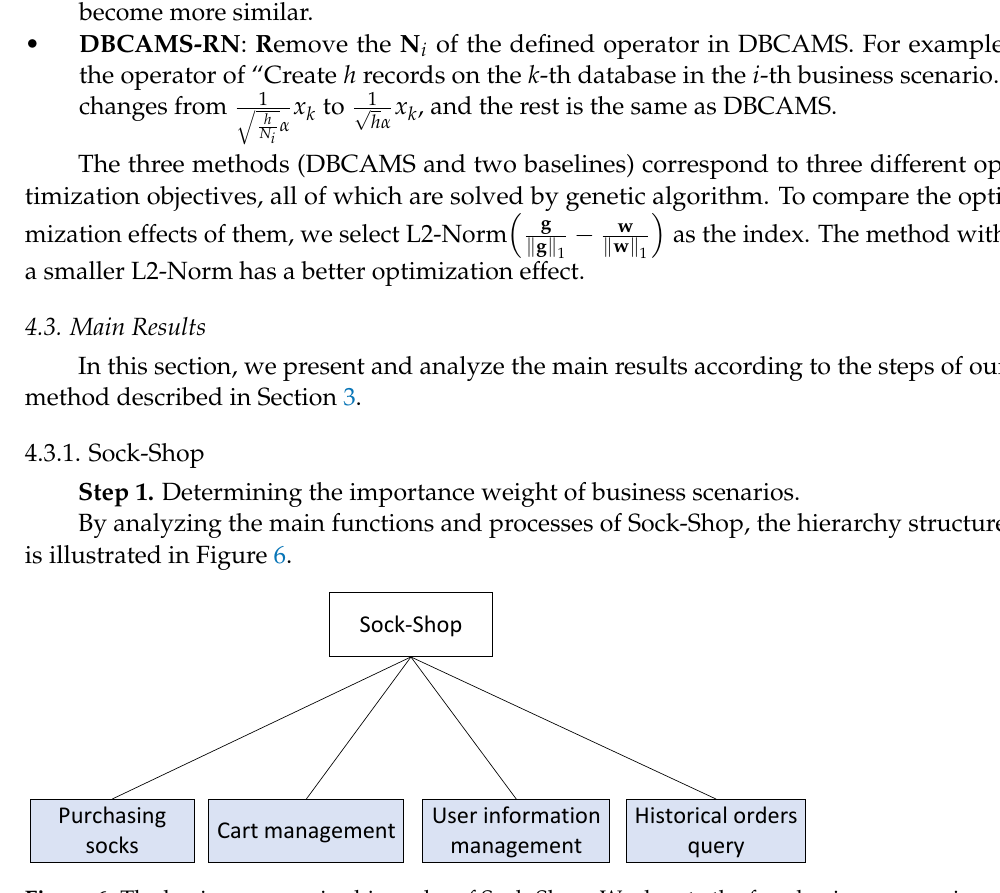
Figure 6. The business scenarios hierarchy of Sock-Shop. We denote the four business scenarios of Purchasing socks , Cart management , User information management , and Historical orders query as BS 1 , BS 2 , BS 3 , and BS 4 , respectively.